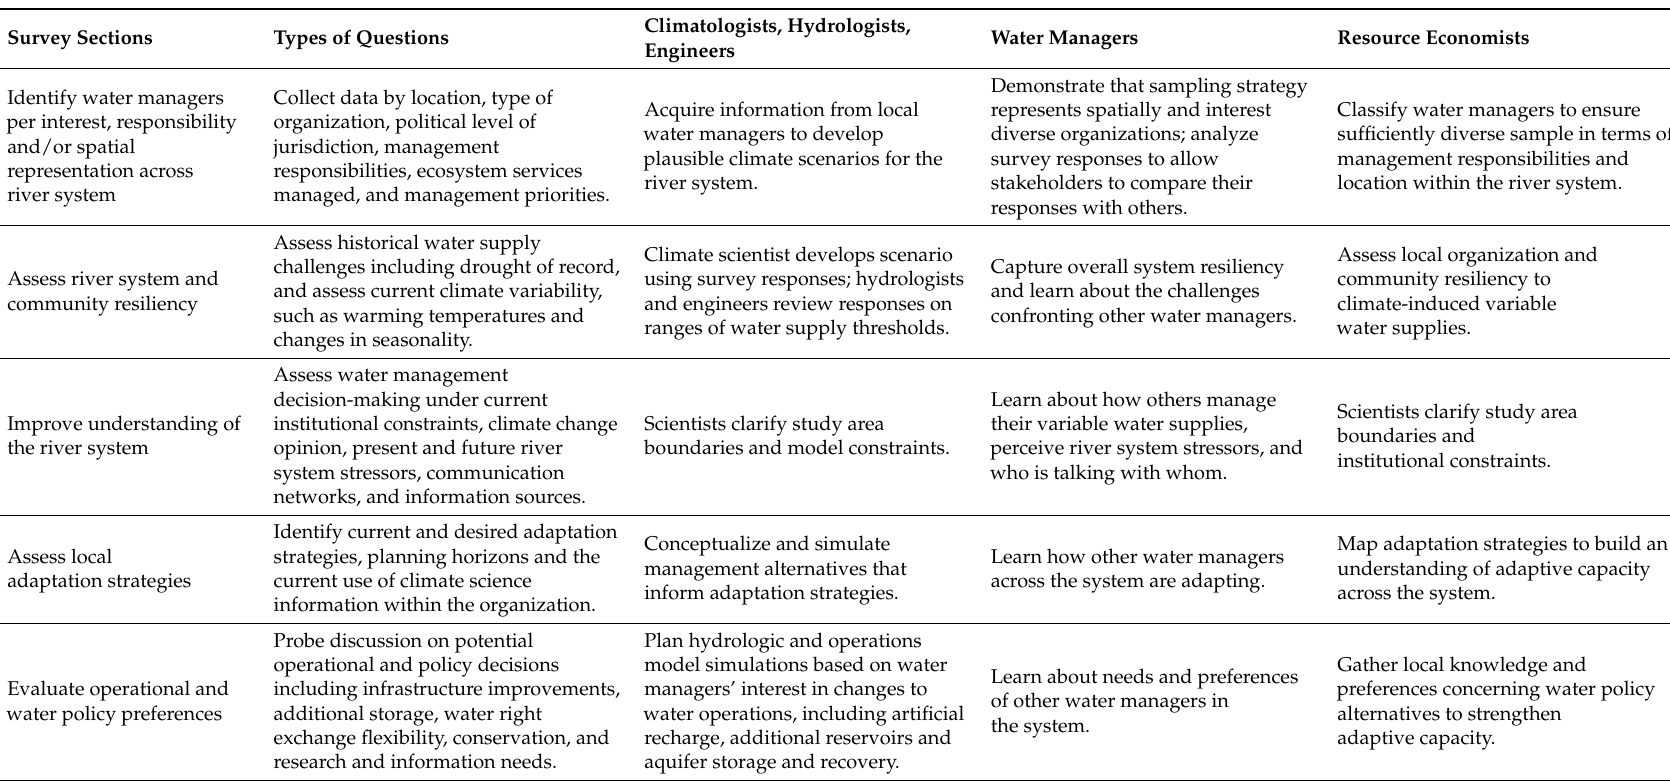
Table 2. Resiliency assessment information purpose and uses. Survey sections are organized by types of questions developed to access local knowledge to inform climate, hydrologic, and resource economics